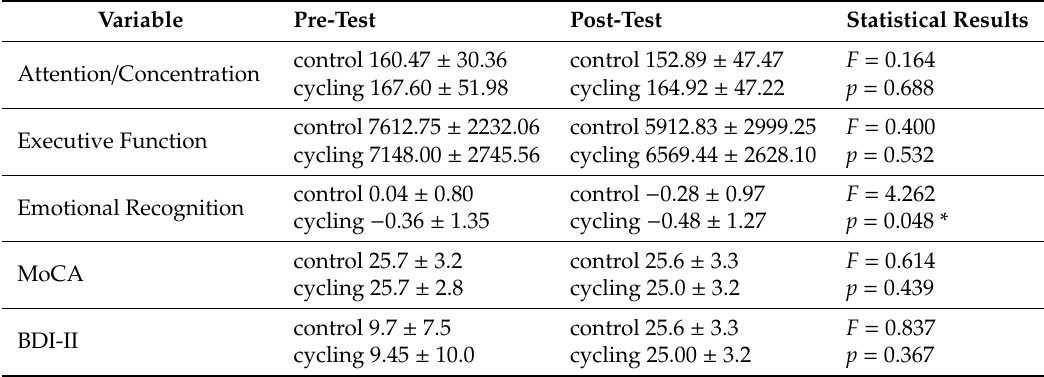
Table 3. Outcome